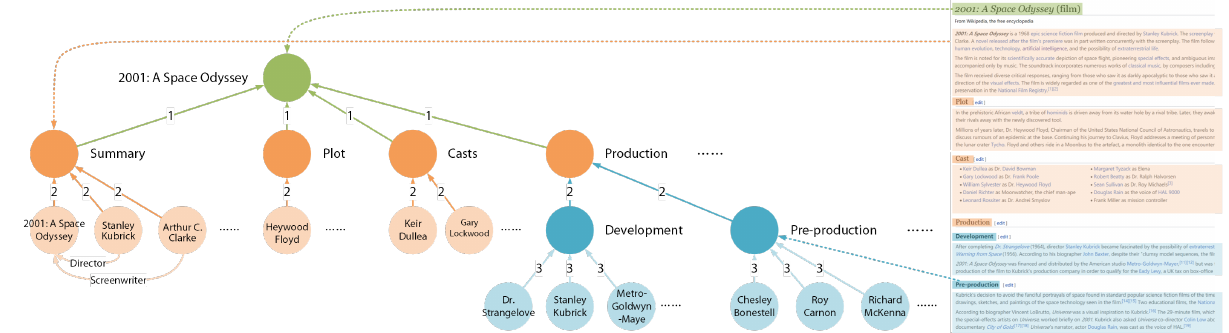
Figure 2. An example of metaknowledge extracted from Wiki documents. The number on the arrows indicates the hierarchical levels of the relations, which are also the weight of